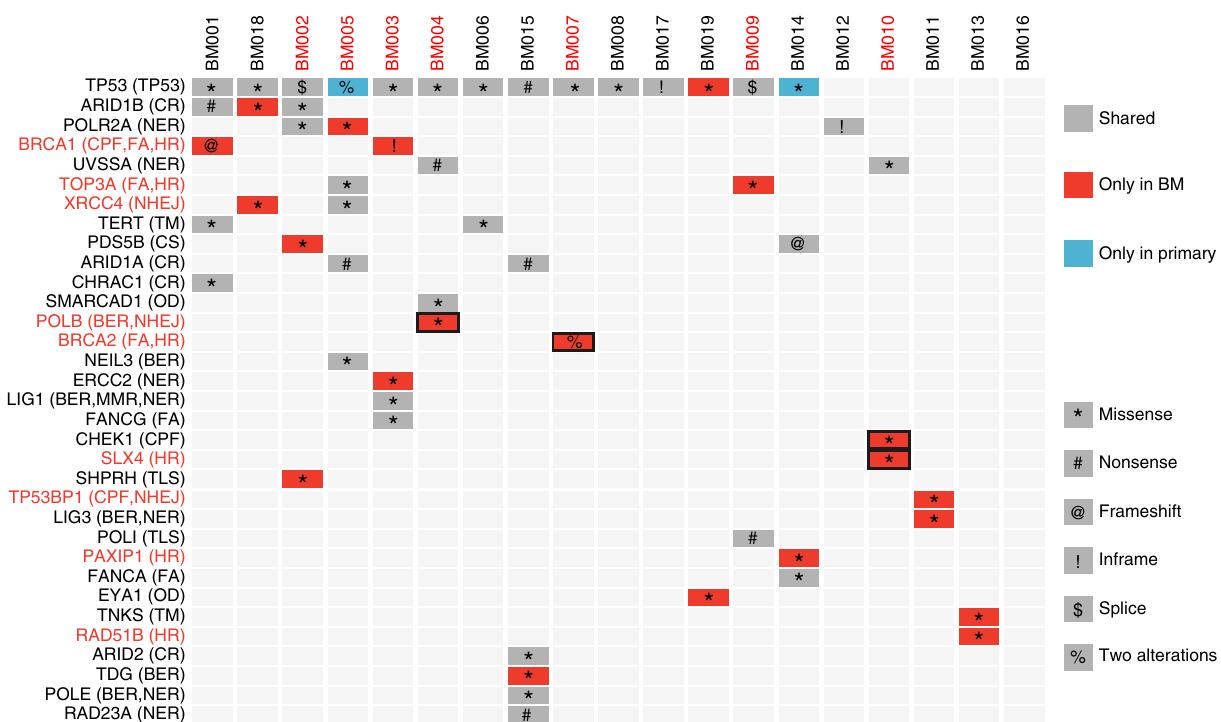
Fig. 2 Mutational spectrum of DDR genes in brain metastases and matched primary tumors of CRC patients. Mutations occurring only in BM tissues are presented in red, and mutations occurring only in primary tissues are presented in blue; shared mutations are presented in grey. Genes involved in homologous recombination and nonhomologous end joining are marked in red. Bold rectangle indicates that the mutations appear in the founding clones